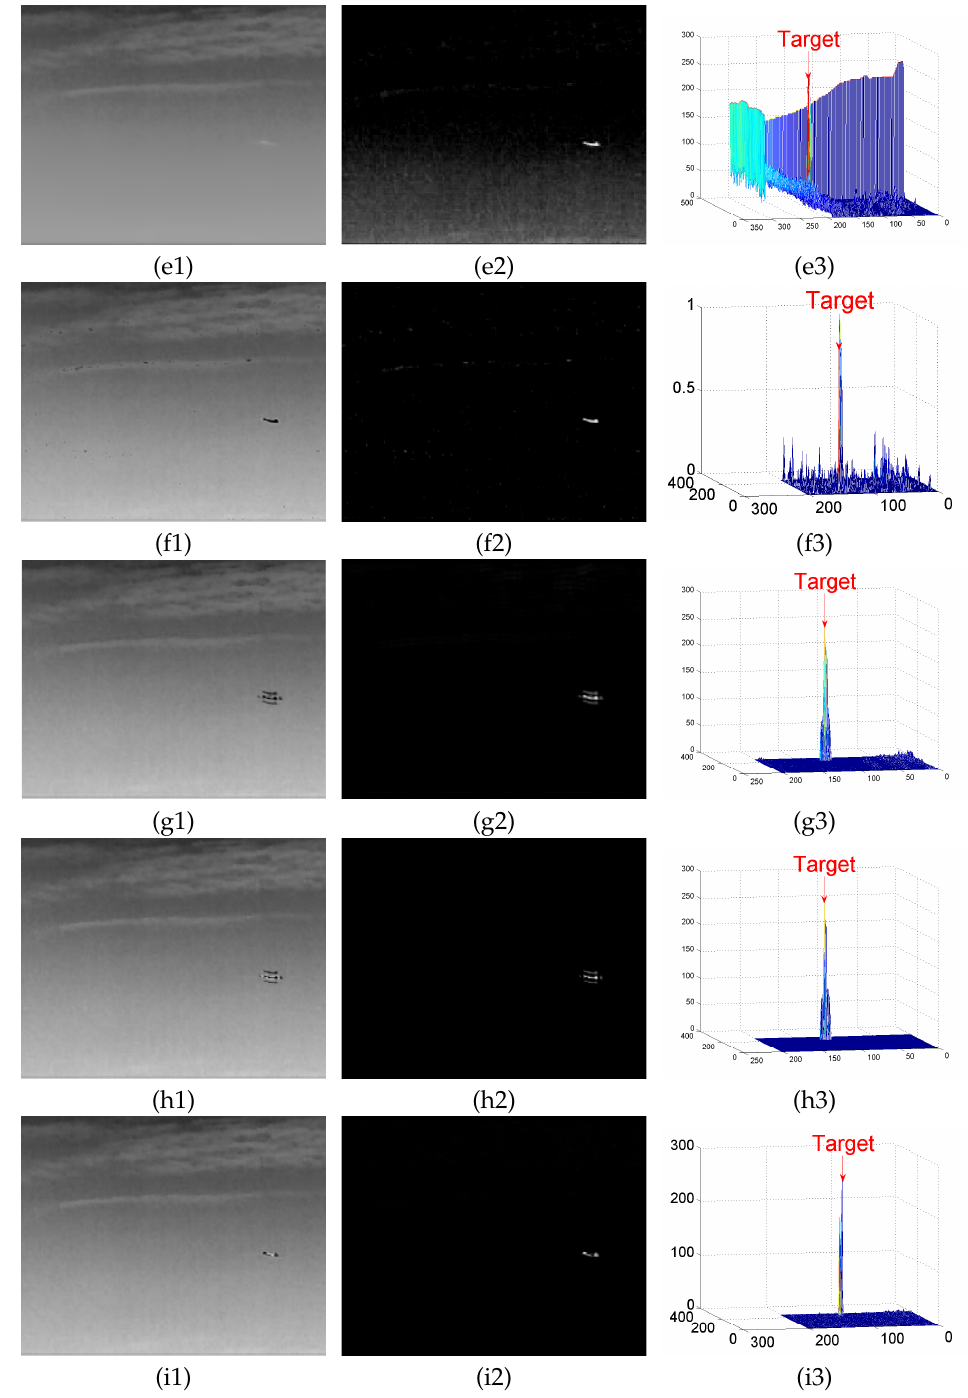
Figure A6. ( a – i) denote the detection results of the PSTNN, RPCA, TV-PCP, VNTFR, ASTTV, SRWS, C2, C3, and proposed algorithm on sequence G, respectively, where ( a1 – a3 ) denote the background map, the differential map, and the 3D map of the obtained differential map,